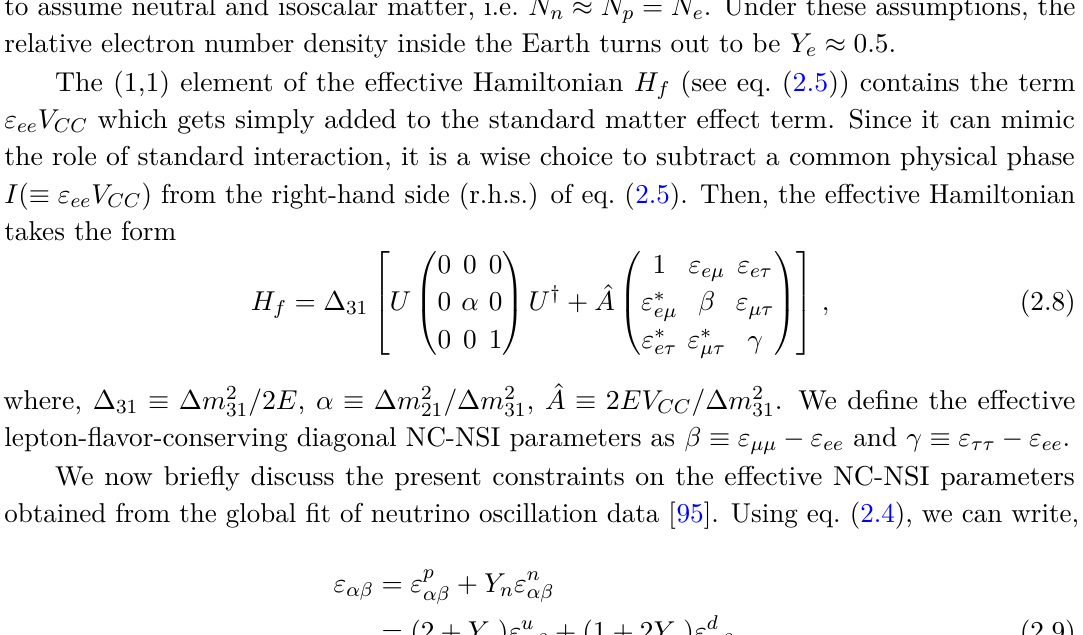
= N . Under these assumptions, the ≈ N n p e ≈ 0 . 5 e